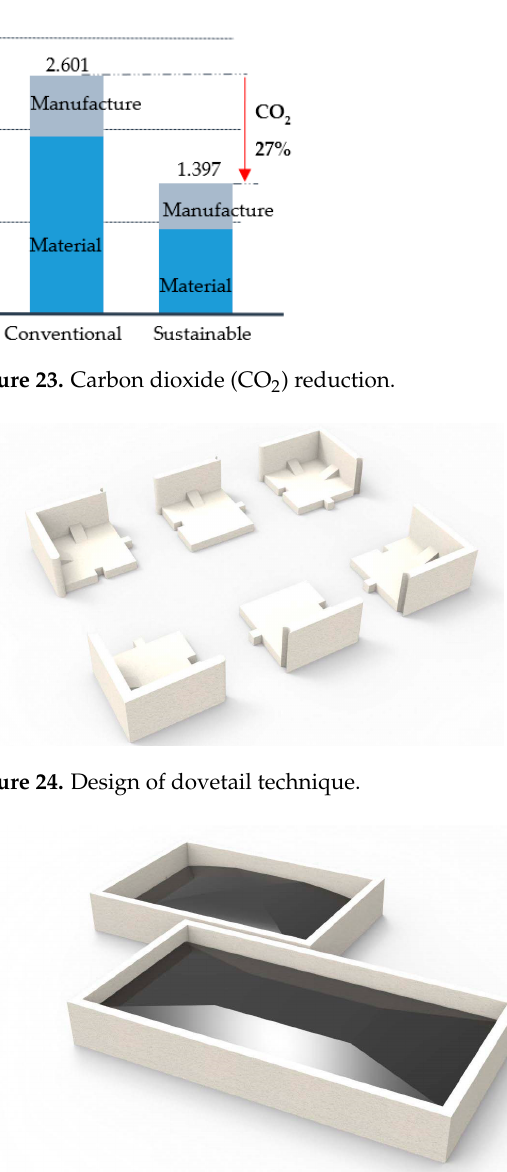
Figure 26. Cushion Figure 26. Cushion rib.